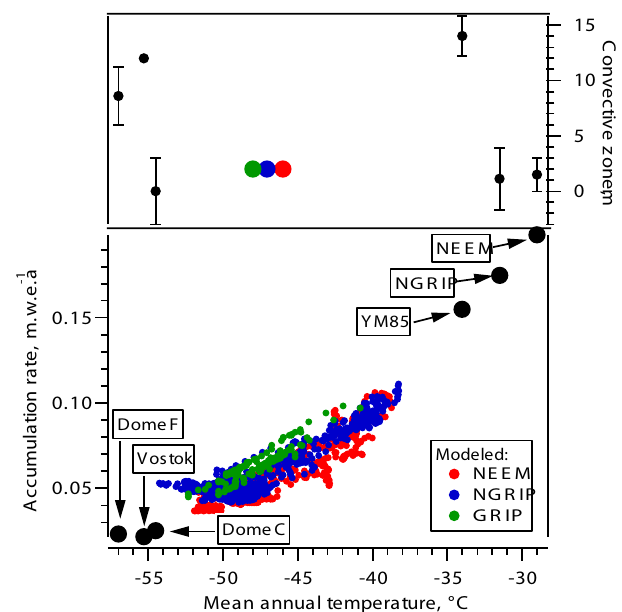
Fig. A2. Bottom: accumulation rate (m.w.e.a − 1 ) vs. temperature ( ◦ C). NEEM (red), NGRIP (blue) and GRIP (green), modeled dur- ing MIS3. Black dots: measured for different present-day sites. Top: convective zone (m) vs.